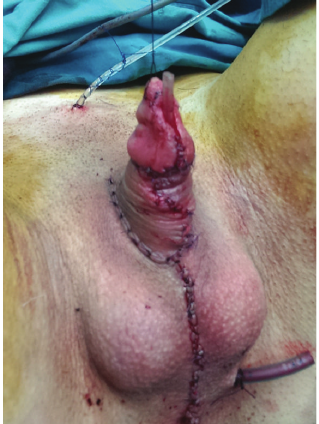
Figure 5: Appearance at the end of surgery. Penile skin recon- structed using remaining genital skin. Two testicular implants inserted into scrotums created from both labia